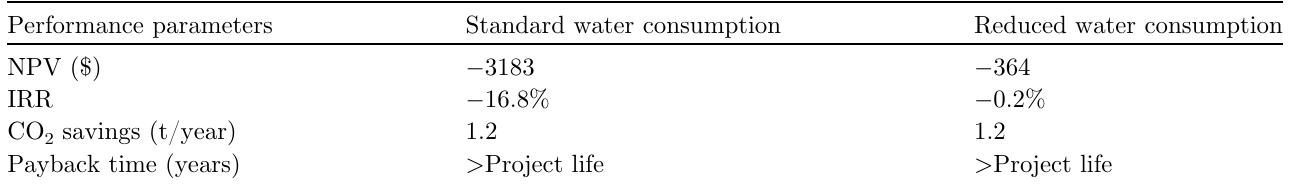
Table 1. Performance indicators for standard and reduced water consumptions for the solar thermal system simulation.